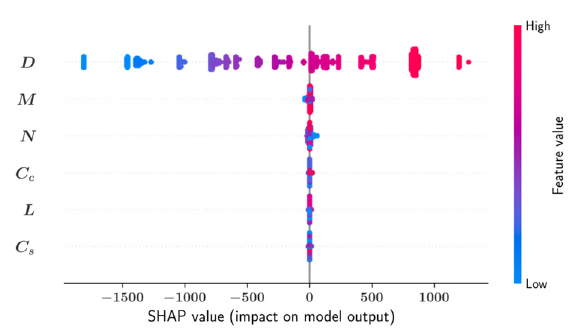
Figure 7. SHAP summary plot for A s (Random Forest)